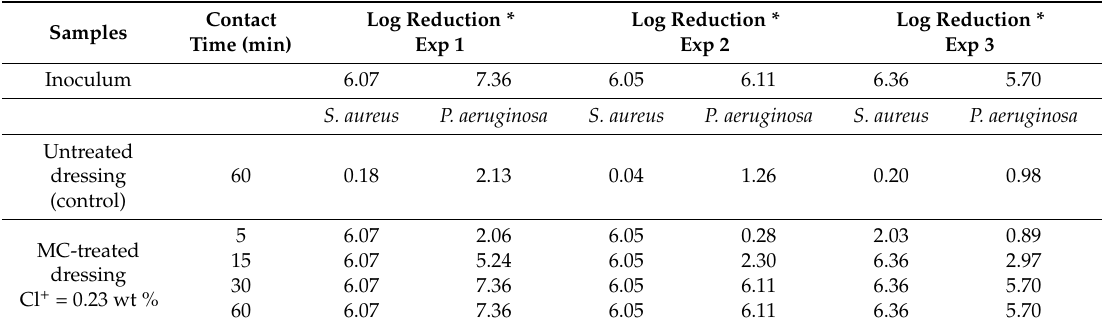
Table 2. Biocidal efficacy of MC-treated wound dressings.